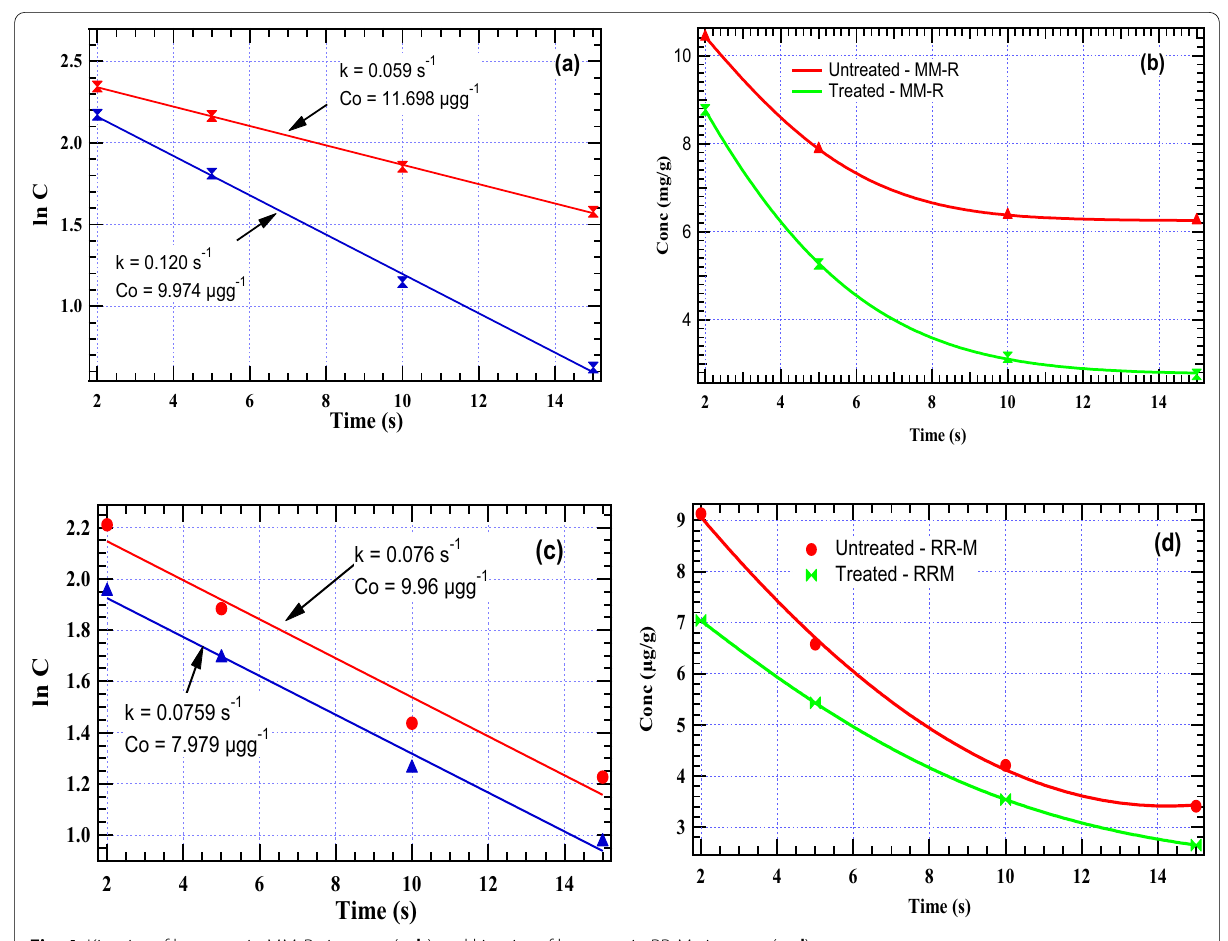
Fig. 4 Kinetics of benzene in MM-R cigarette ( a , b ) and kinetics of benzene in RR-M cigarette ( c , d